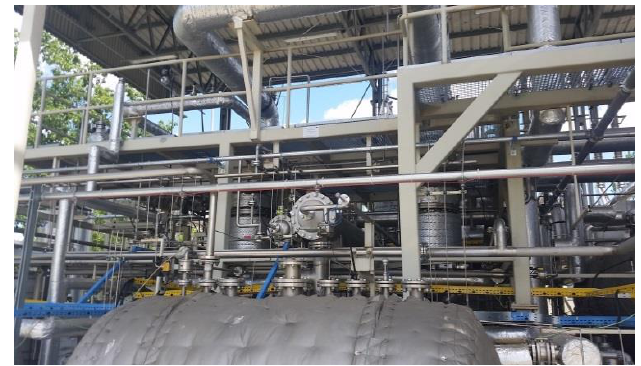
Figure 6. Photo of a fragment of the liquefaction system of post-cracking products and one of the intermediate